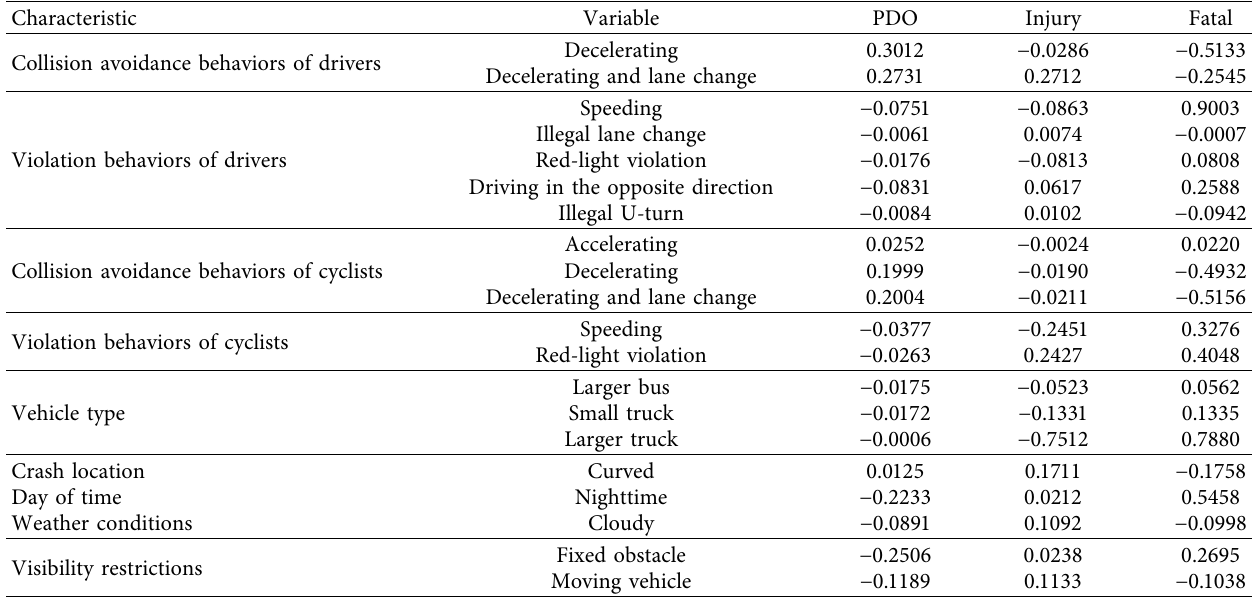
Table 3: Elasticity analysis of the RPL model for cyclist injury severity